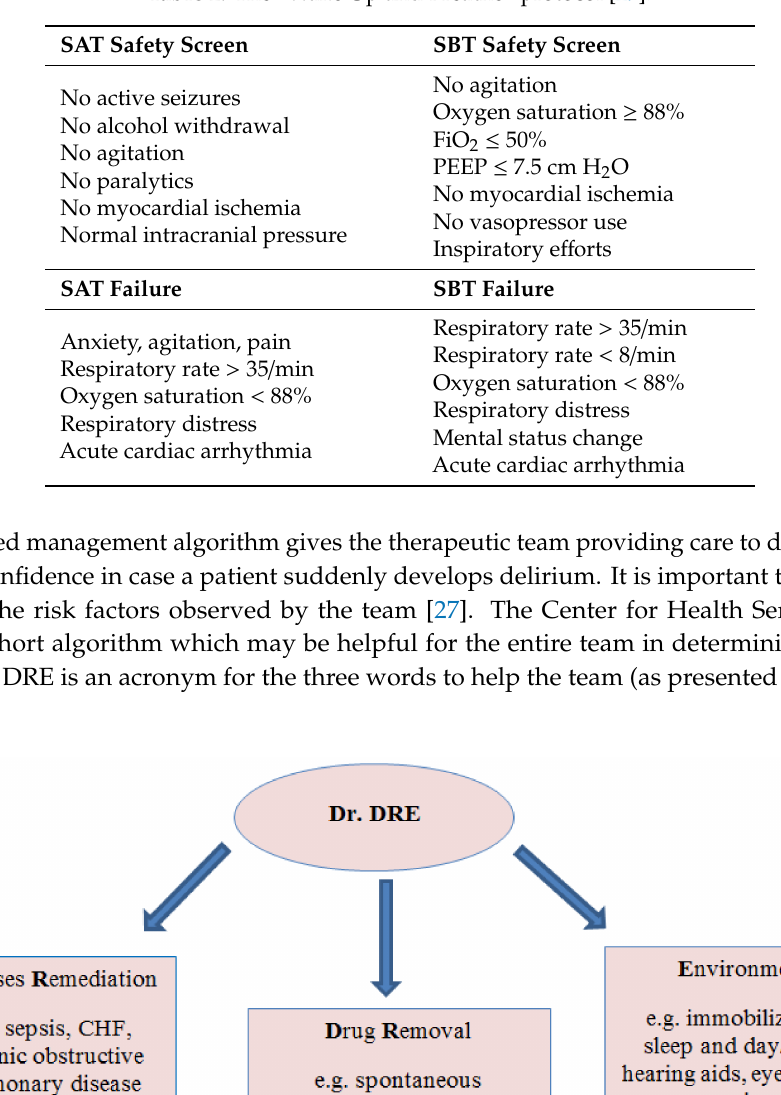
Table 2. The “Wake Up and Breathe” protocol [29].